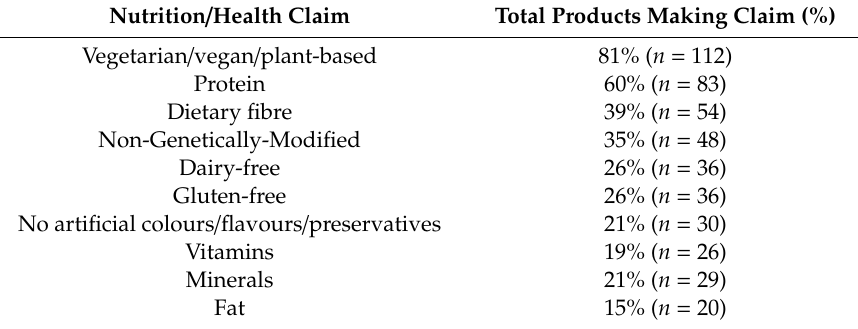
Table 6. Most frequent nutrition content- and health-related claims on